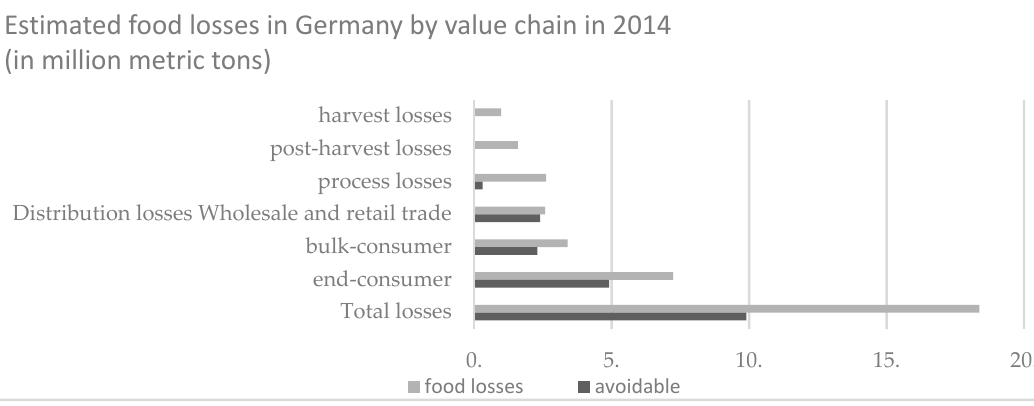
Figure 2. Estimated food losses in Germany by value chain in 2014, adapted from [8].